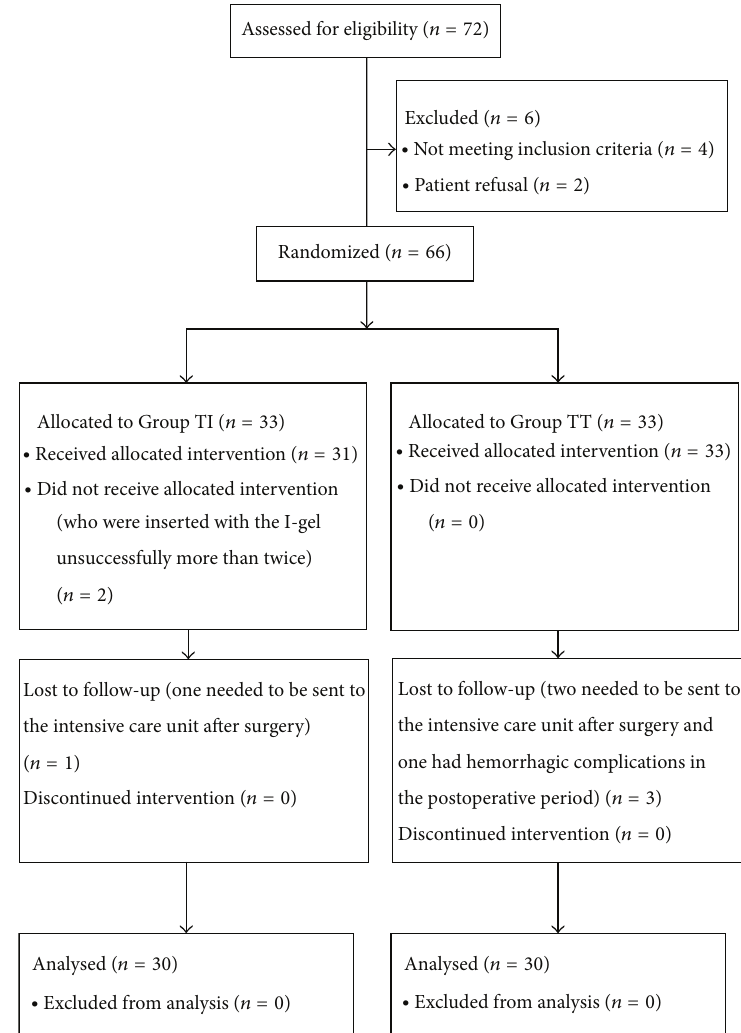
Figure 1: Flow diagram of patient